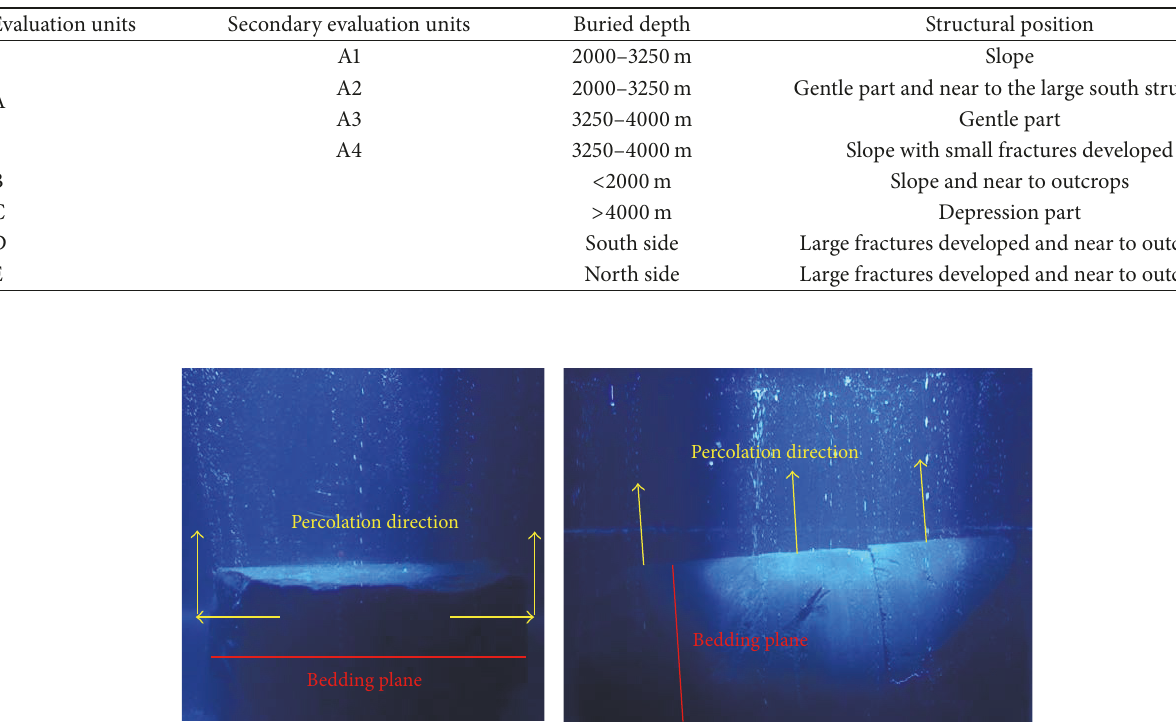
Table 2: Divisions of evaluation units.